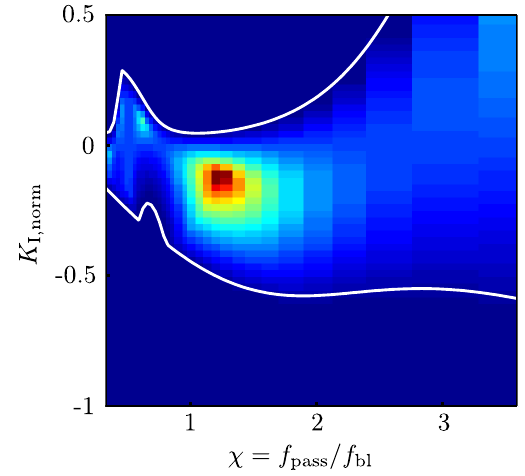
FIG. 13. Eigenvalue analysis of the discrete-time linear model of scan 1 and stability margins (white line).